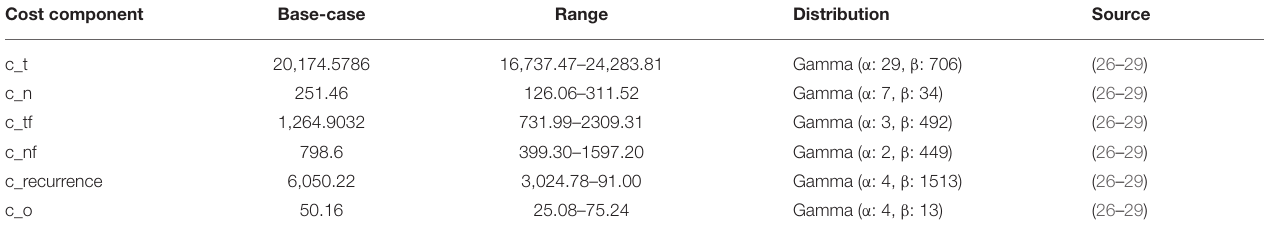
TABLE 2 | Cost variables for the